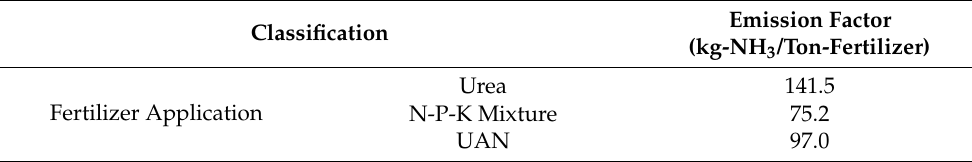
Table 4. Emission factor of fertilizer-use agricultural land emission sources used in